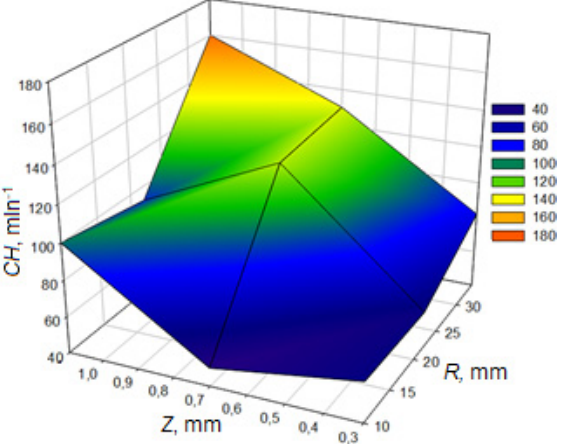
Figure 12. The dependence of the CH content on the spark plug gap and the resistance of the catalytic converter (at the capacity of the electromagnetic nozzle F = 106% = const and a 20% throttle opening degree)